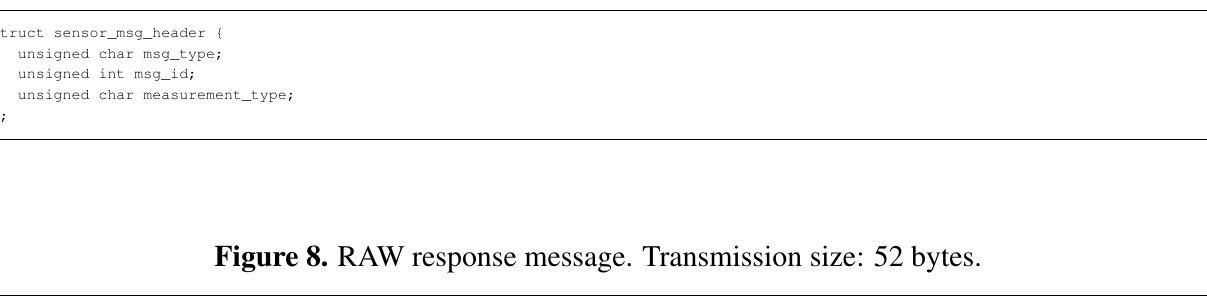
Figure 7. RAW request message. Transmission size: 4 bytes.